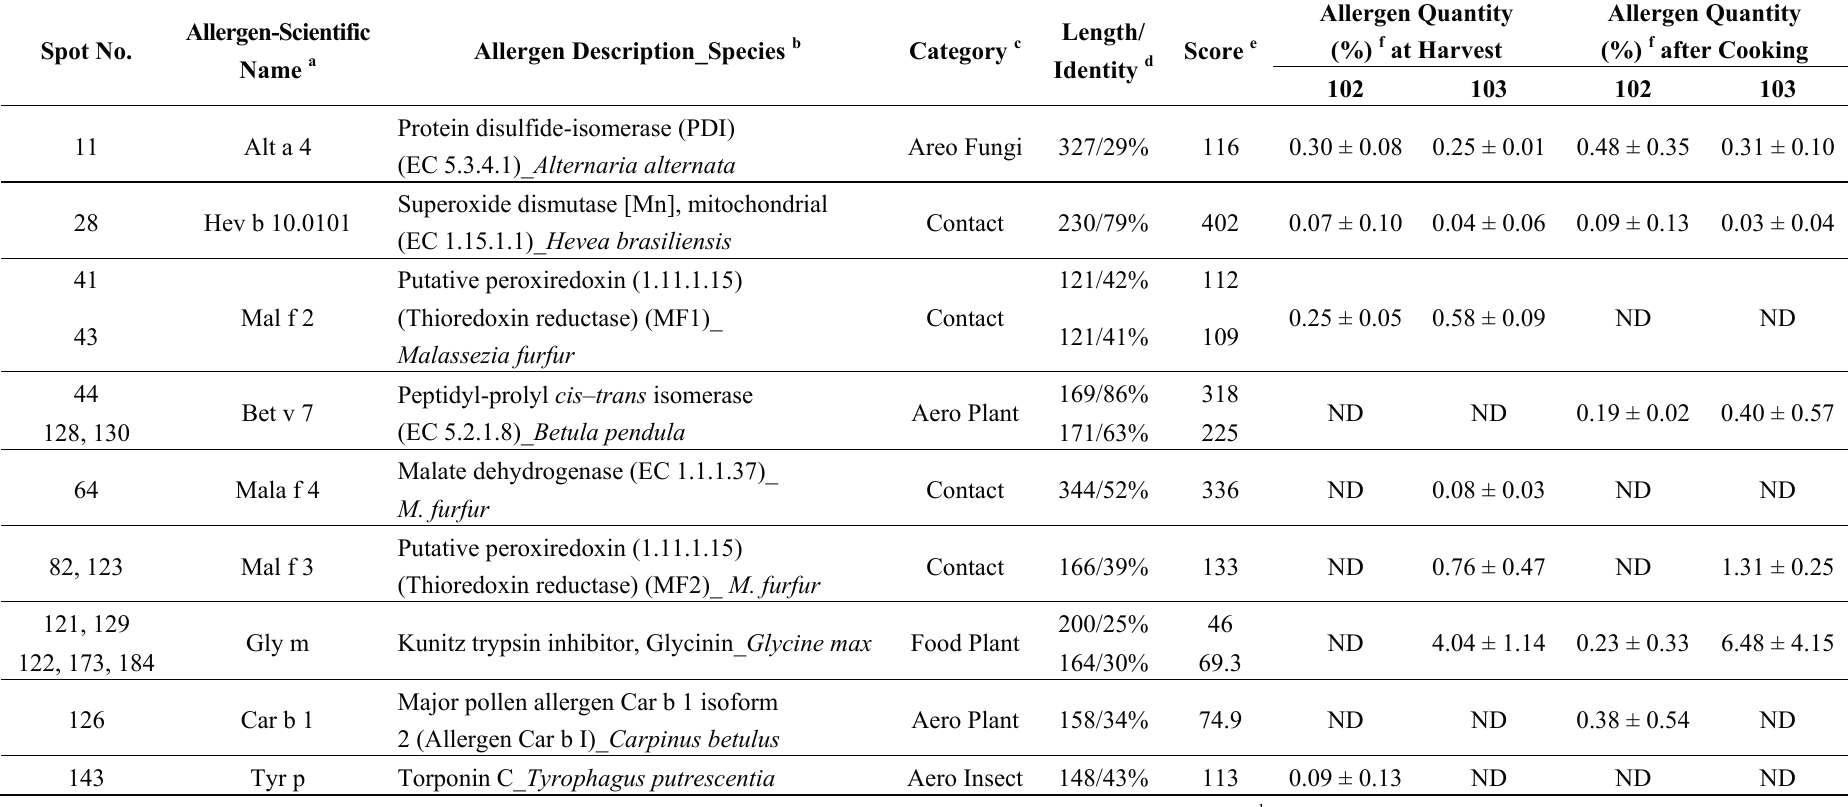
Table 5. Putative protein allergens in ipt -transgenic lines 102 and